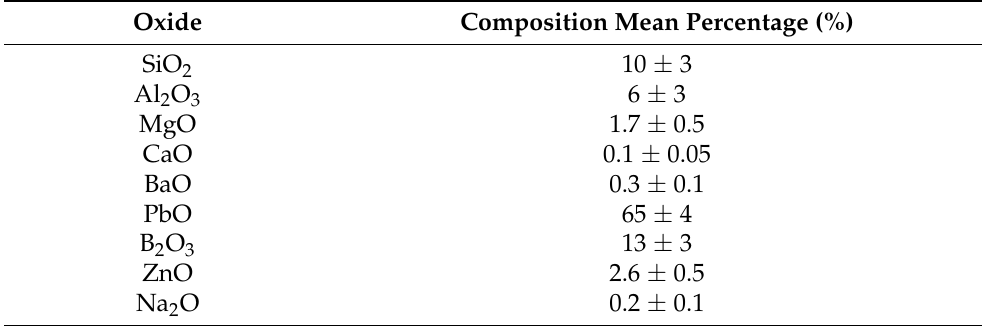
Table 1. Contained oxides and their percentage in the glass frit